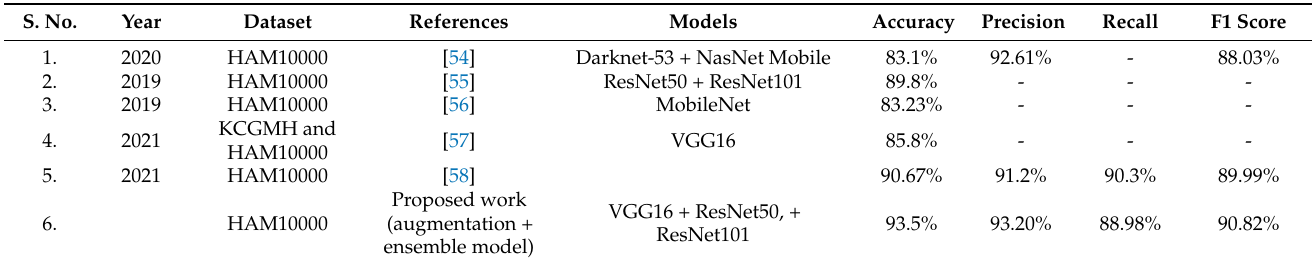
Table 6. Comparative